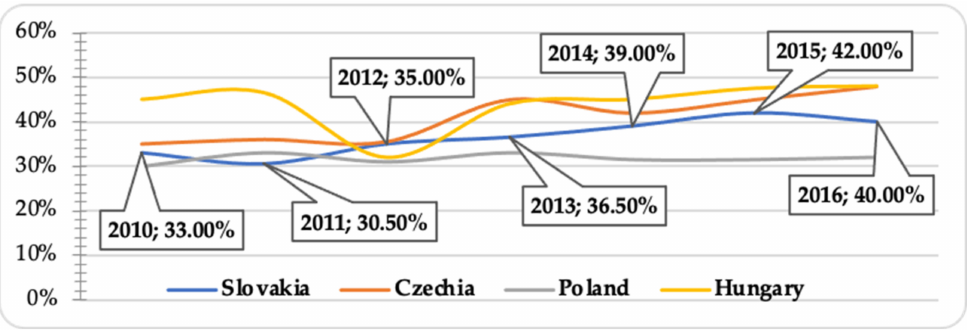
Figure 4. Gross value-added under V4 2010–2017 per employee. Source: Authors’